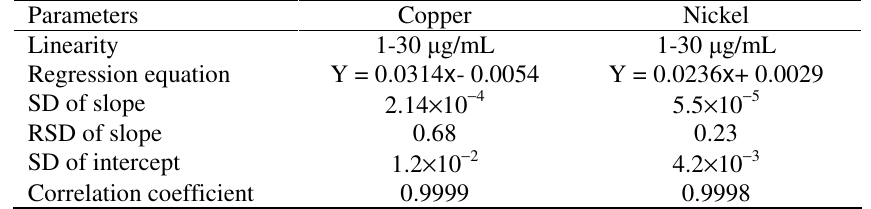
Table 1. Statistical data of calibration curves of Cu-NDTT and Ni-NDTT in mixtures with different concentrations using third derivative spectra.